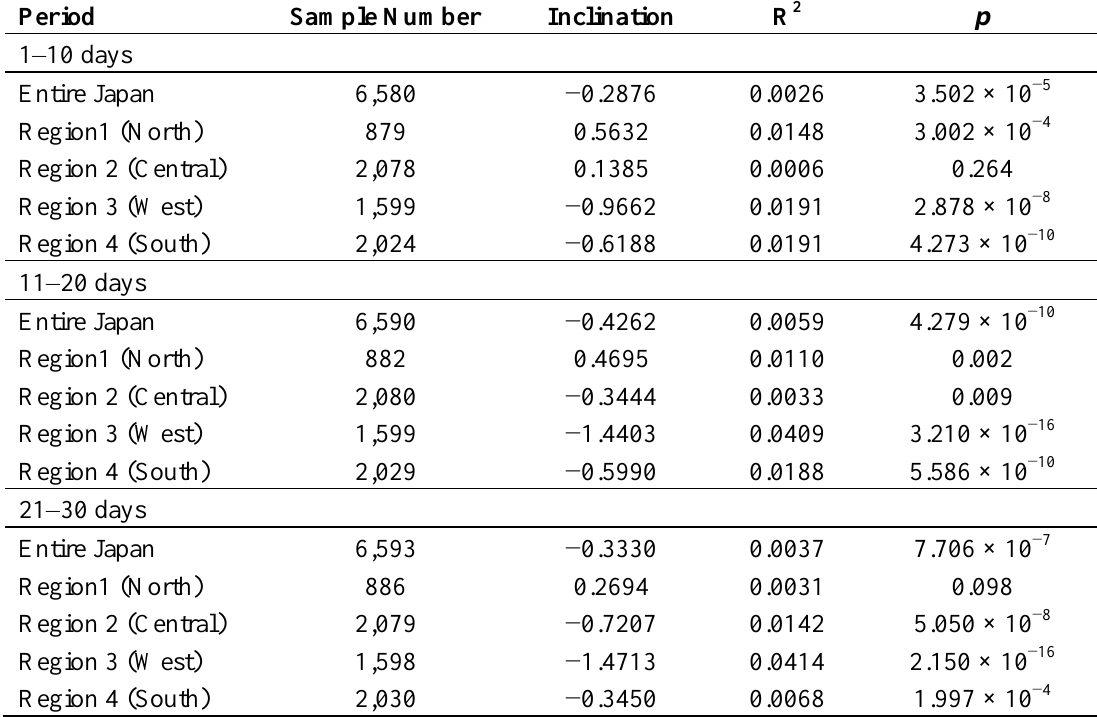
Table 2. Effect of the precipitation during preceding 10-day periods from day 1 to day 50 before blood collection on the maximum sero-conversion rate to JE virus in sentinel